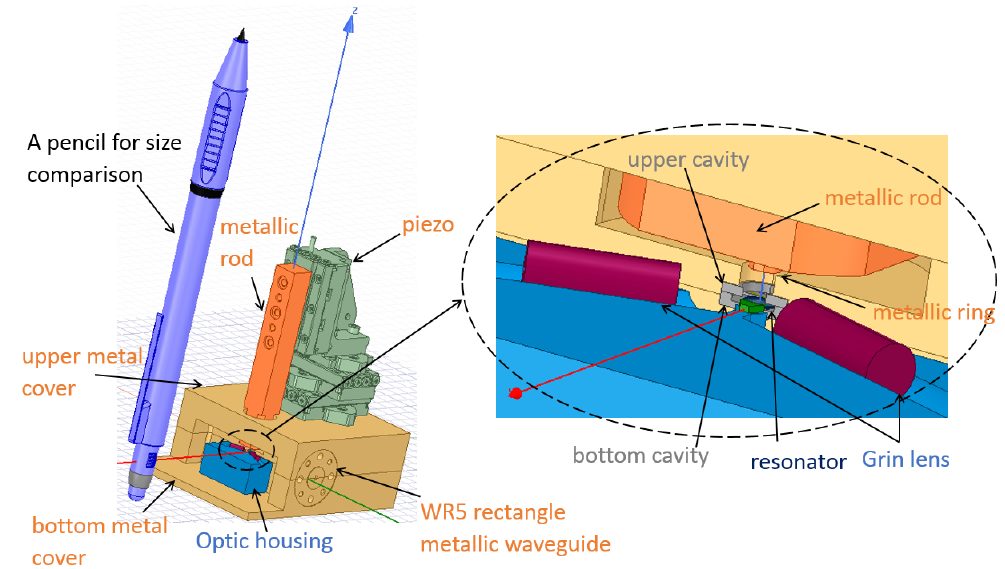
Figure 9. Overview of the integrated